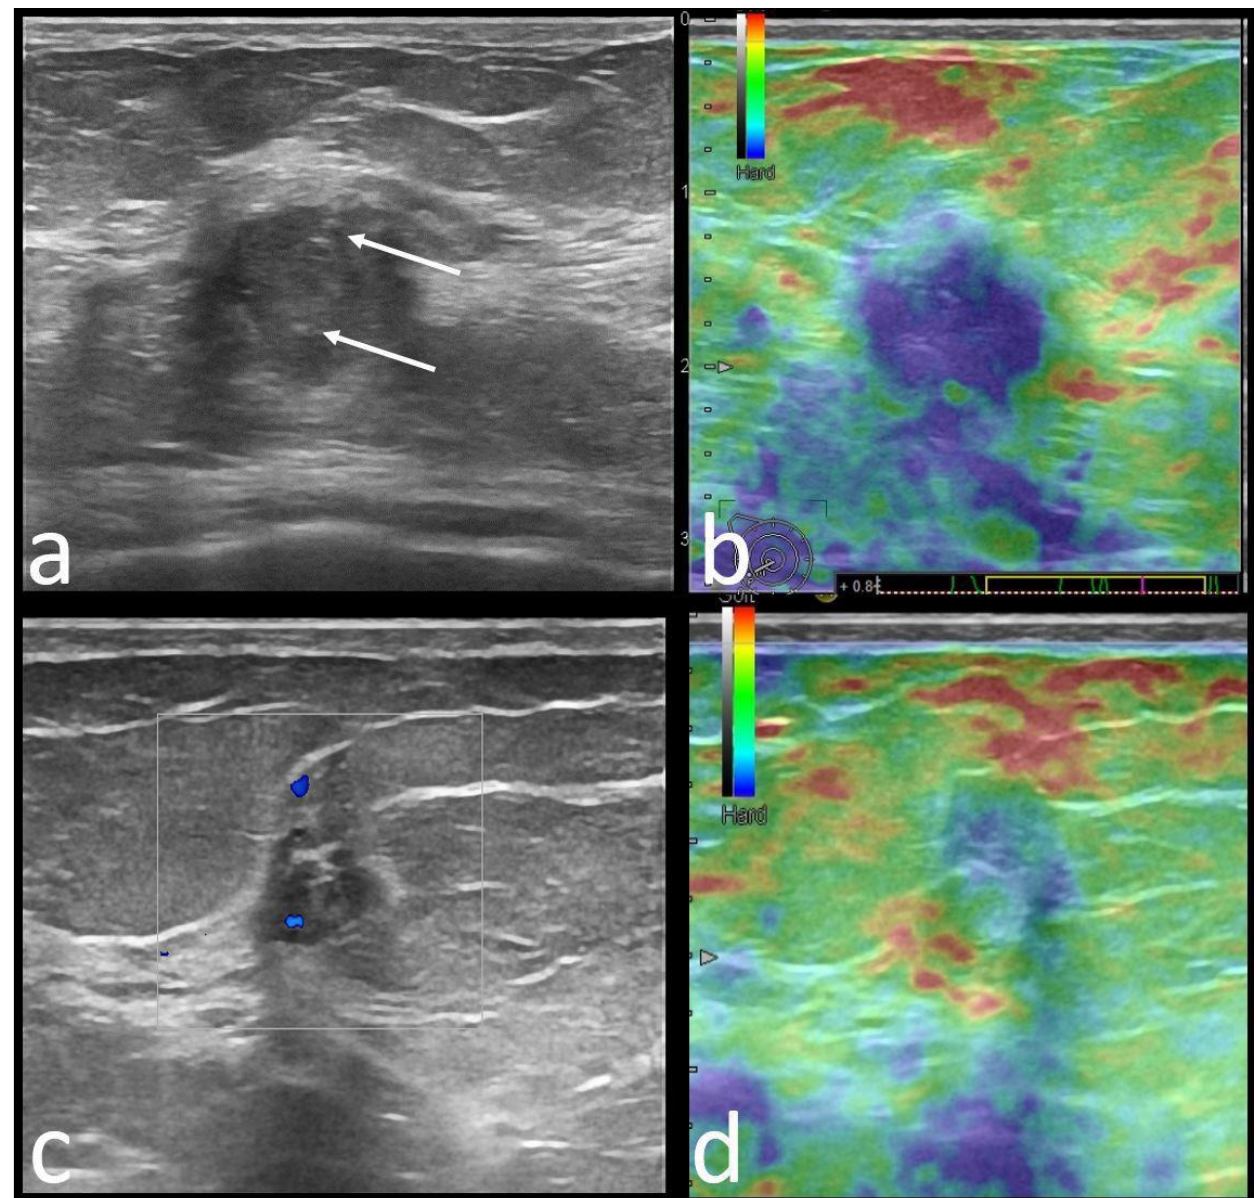
Figure 5. Upper images: 66-year-old ATM mutation carrier patient with right breast cancer. There is an irregular, isoechoic mass with indistinct margins, non-parallel orientation compared to skin ( a ), and soft elastography appearance (TSUKUBA score 3, b ). Two punctate microcalcifications are seen within the mass (arrows), confirmed on mammography (not shown). Pathology: IDC-NST, ER/PR-positive, HER2-negative, Ki67 = 14%. Lower images: 43-year-old CHEK2 mutation carrier patient with right breast cancer. There is an irregular, heterogeneous mass with indistinct margins, parallel orientation compared to chest wall, with mild posterior acoustic shadowing, internal vascularity ( c ), and soft elastography appearance ( d , TSUKUBA score 2). Pathology: IDC-NST, ER/PR-positive, HER2-negative, Ki67 = 13%.